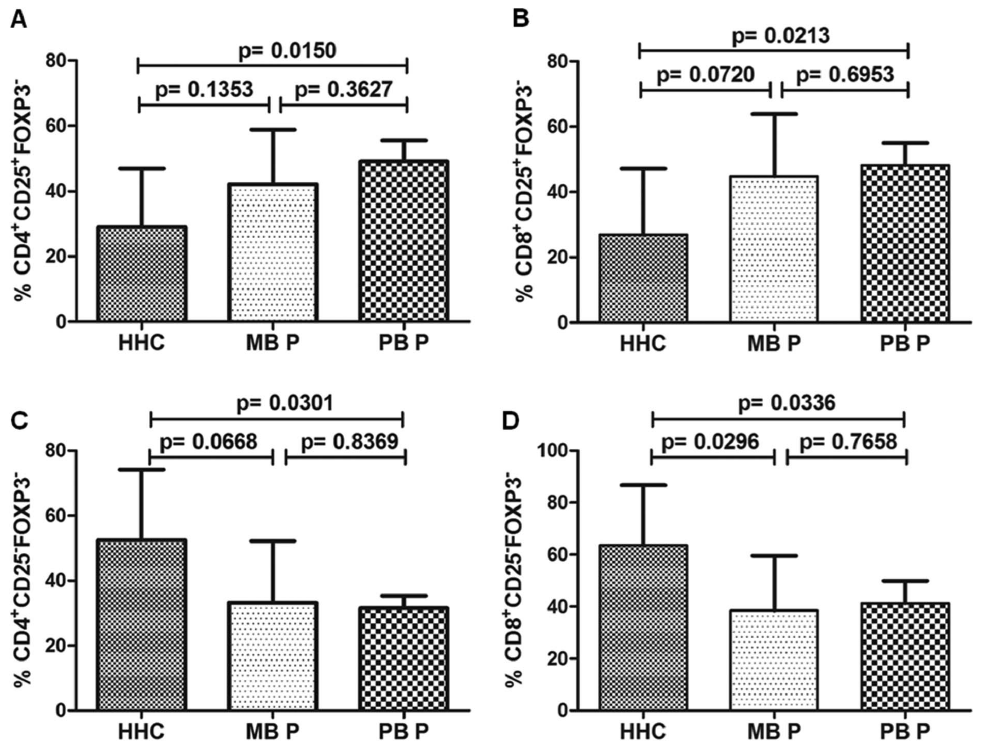
Figure 4. CD4 + /CD8 + CD25 + FOXP3 2 and CD4 + /CD8 + CD25 2 FOXP3 2 frequency in leprosy patients and contacts. The frequency of CD4 + / CD8 + CD25 + FOXP3 2 and CD4 + /CD8 + CD25 2 FOXP3 2 cells in CD4 + or CD8 + lymphocyte gate after 72-hour culture of peripheral blood mononuclear cells with anti-CD3 and anti-CD28 associated with total sonicated fraction of M. leprae. Comparison between household contacts (HHC), multibacillary patients (MB P) and paucibacillary patients (PB P), with regard to frequency of CD4 + CD25 + FOXP3 2 (A), CD8 + CD25 + FOXP3 2 (B), CD4 + CD25 2 FOXP3 2 (C) and CD8 + CD25 2 FOXP3 2 (D) cells. Unpaired two-tailed Student t-test, p # 0.05 was considered significant. Results are presented as mean with SD.